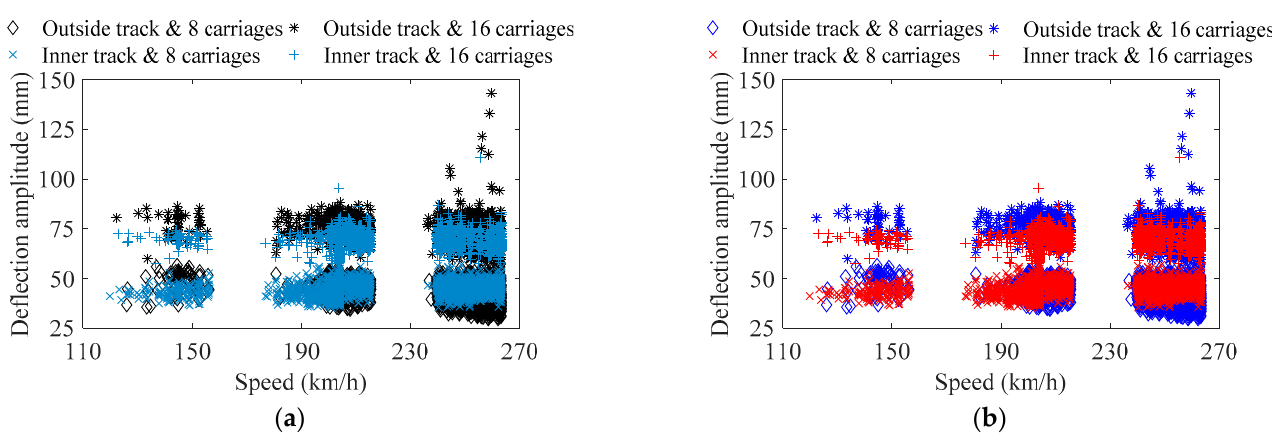
Figure 10. Cases for 8 and 16 carriages for train-induced deflection amplitude by clustering: ( a ) hierarchical clustering; ( b ) k -means clustering ( k = 2).